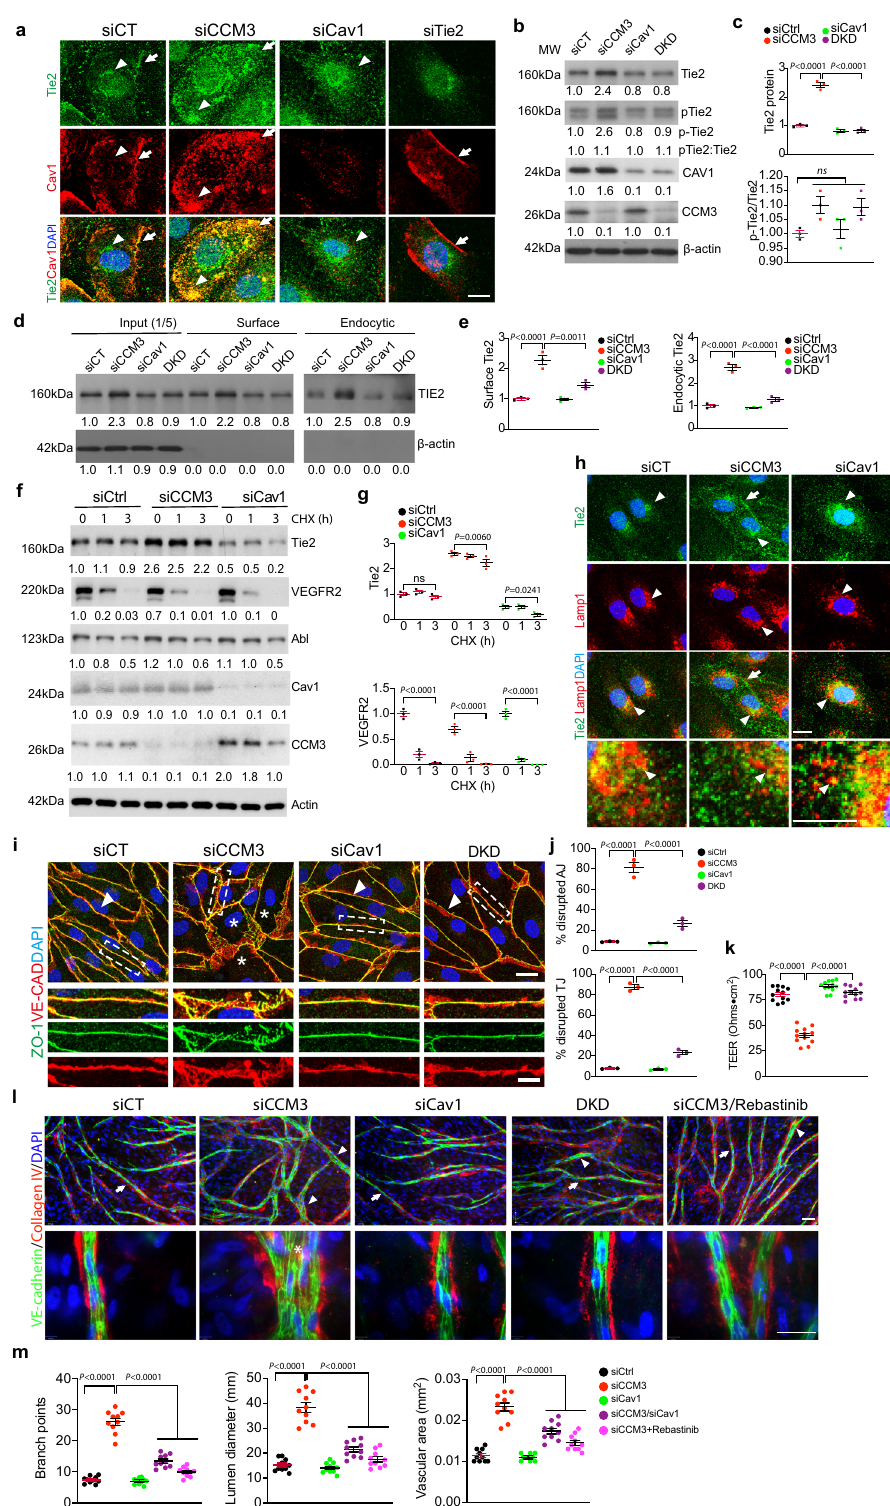
Cav1 silencing. Using mouse genetic approaches, we show that vascular integrity. Our study reveals a mechanism by which Cav1 de fi ciency prevents Tie2 signaling and blocks CCM lesion CCM3 mutation-induced Cav1-Tie2 signaling contributes to the development caused by brain EC-speci fi c Ccm3 inactivation. progression of the CCM disease (Fig. 10). Importantly, our results demonstrate that a Tie2 inhibitor A key fi nding of the current study is the visualization of the Rebastinib (a phase 1b/phase 2 clinical trial drug) ameliorates vasculature and EC-pericyte interactions during CCM lesion CCM lesion progression in the mouse CCM models, correlating progression using confocal and two-photon microscopy. Previous with normalized EC junction, EC-pericyte interaction, and studies from human samples 1 – 3 and CCM2-de fi cient mouse NATURE COMMUNICATIONS| (2021) 12:504